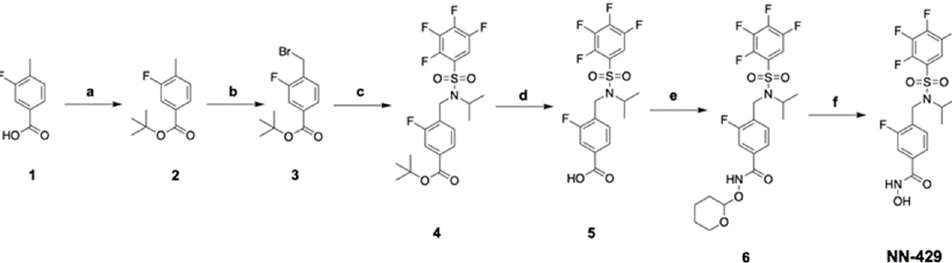
Figure 1. Crystal structure of NN-390 in the active site of HDAC6 surrounded by side chains of interacting residues. A close-up of the catalytic pocket shows the interaction mode of the hydroxamate moiety with the Zn 2+ ion (blue-gray sphere) via a bidentate metal coordination (dashed black lines) and the surrounding residue side chains.